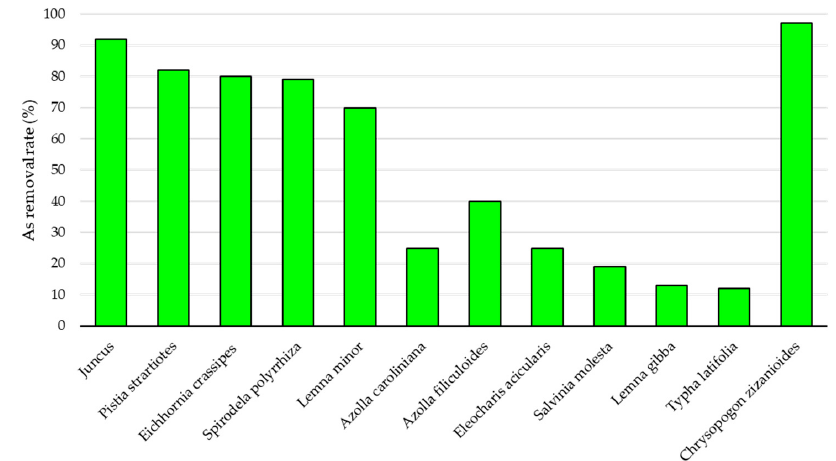
Figure 6. Comparison of Chrysopogon zizanioides and macrophytes plants used for phytoremediation (adapted from [47]).